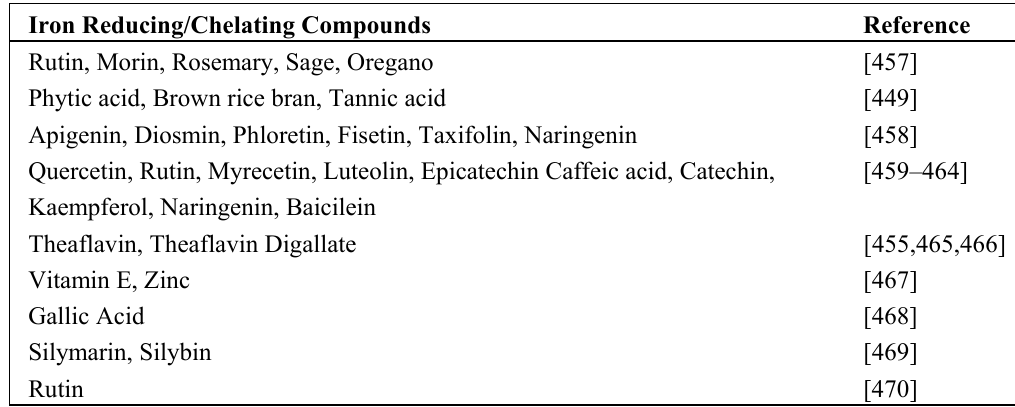
Table 8. Iron Reducing/Chelating